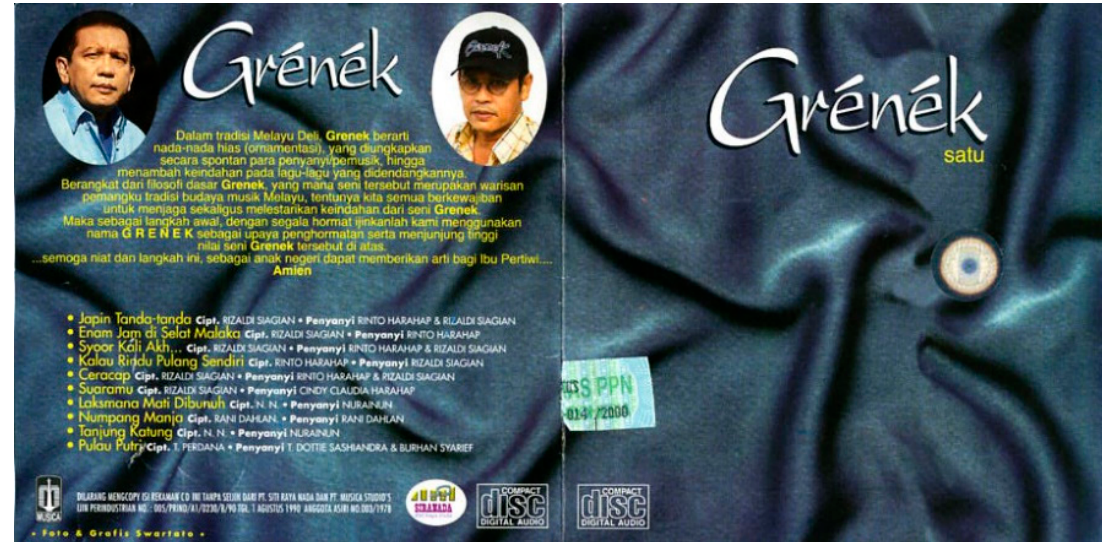
Figure 4. Cover of Grénék Satu audio CD.